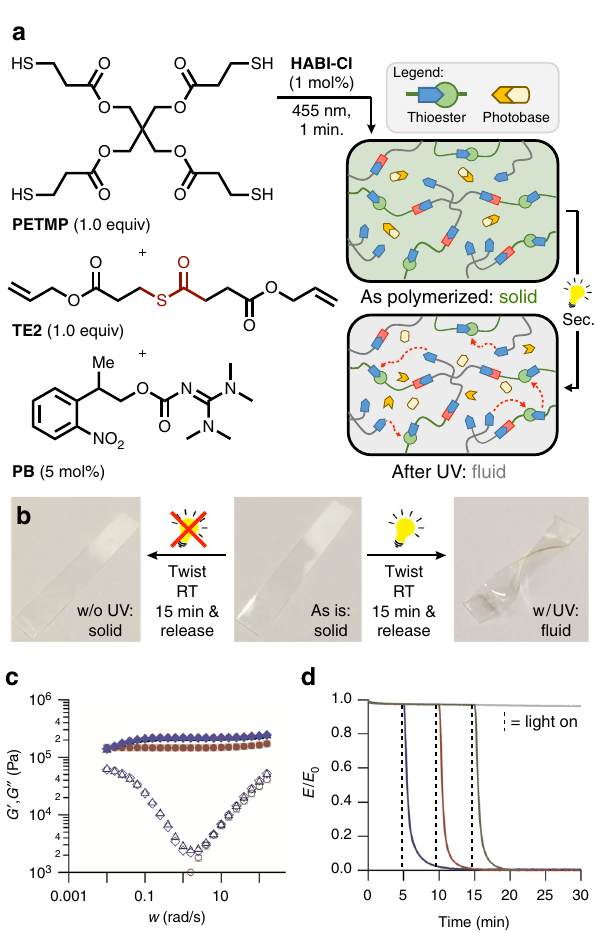
Fig. 3 Permanent, instantaneous switching of a fl uid to a solid. a A general formulation that gives a material which is switched from a fl uid to a solid with UV light. b As is, the fl uidic sample forms a new permanent shape when twisted; however, after irradiation (5 min, 365 nm, 75 mW/cm 2 ) the now solid sample does not adopt the new shape. c Rheometry shows that this material acts permanently as a fl uid (immediately after polymerization: G ′ = grey fi lled square; G ″ = grey open square; 1.5 h after polymerization: G ′ = red fi lled circle; G ″ = red open circle) until exposure to UV light, which switches it to a solid (immediately after irradiation: G ′ = black fi lled triangle; G ″ = black open triangle; 1.5 h after irradiation: G ′ = blue fi lled diamond; G ″ = blue open diamond). d The nearly instantaneous solidi fi cation of the material upon exposure to UV light, shown here by the relaxation of stress at a constant strain (10% strain, light on at 5 (blue), 20 (red), and 120 (black) seconds, irradiated for 120 s, 320 – 500 nm, 75 mW/ cm 2 , a small thermal recovery was noted in each case after the light was turned off). Grey line — not irradiated